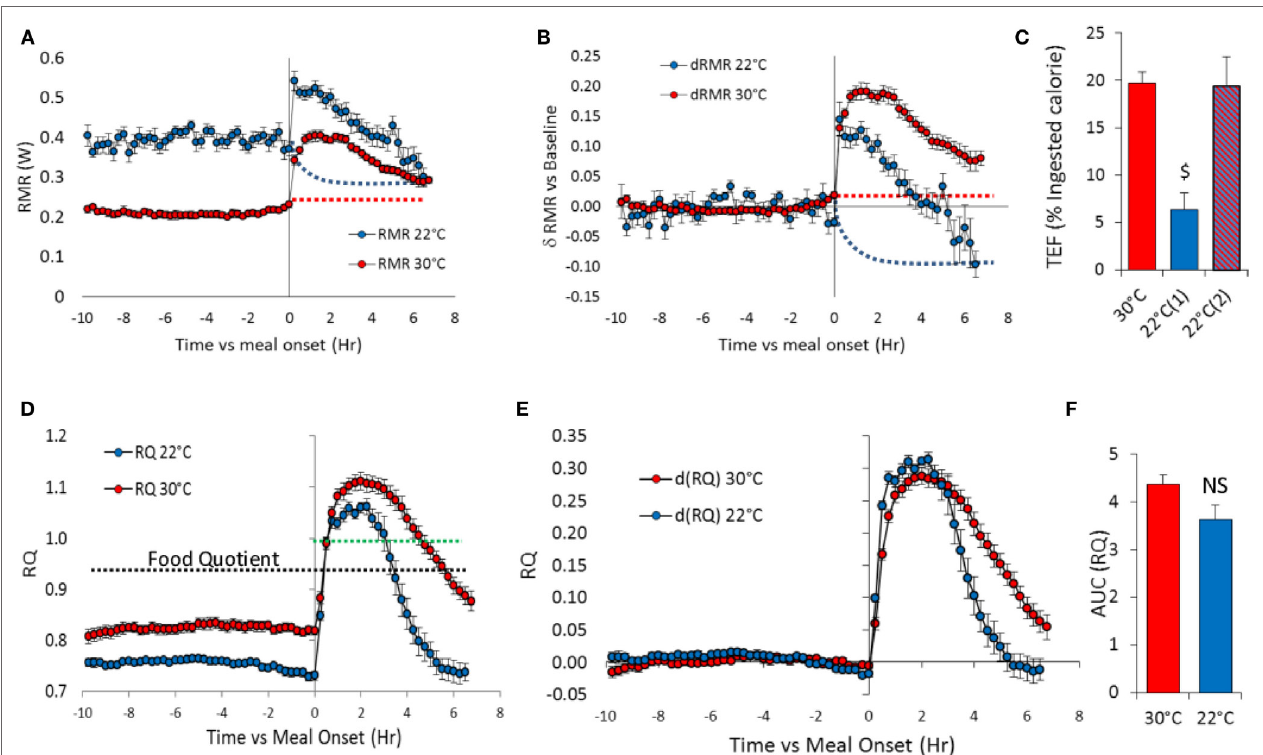
FigUre 4 | Meal induced changes in TMr, rMr (watts), and rQ in overnight fasted mice at 30°c ( n = 11) and 22°c ( n = 10) . Test-meal (1 g, 16 kJ) given at t = 0. (a) Absolute TMR and RMR values, (B) TMR and RMR values relative to pre-meal values, (c) TEF computed as the cumulative increase in RMR over pre-meal values [30 and 22°C(1)] or after taking into account the possible decrease in RMR at 22°C [22°C(2)] [$: P < 10 − 5 vs. 30 and 22°C(2)]. See TEF in kJ Table 1 . Red dashed lines – extrapolation of fasting RMR at 30°C. Blue dashed lines – estimated decrease in RMR induced by activity and TEF used to adjust the calculation of TEF at 22°C [22°C(2)] (D) Absolute RQ values. Black dashed lines – food quotient (0.93). Green dashed lines – figures the RQ value of 1. (e) RQ values above 1 imply that part of the ingested carbohydrates is converted to lipids (lipogenesis). RQ changes relative to pre-meal RQ values, (F) Area under curve (AUC) computed as the cumulative changes in RQ over pre-meal